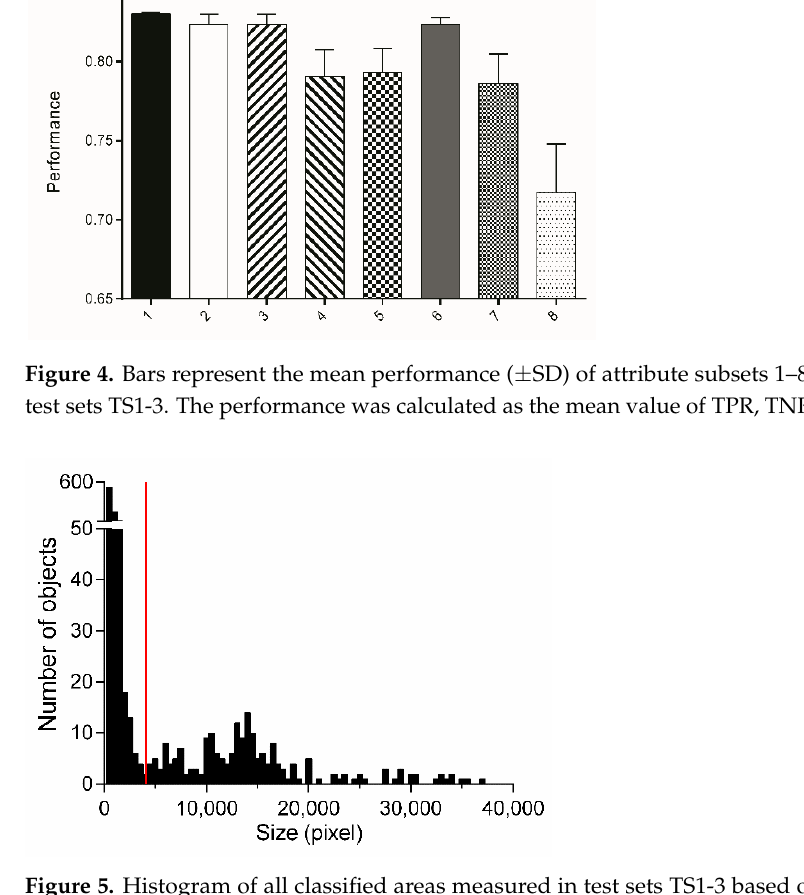
Bars represent the number of objects with a certain area (pixel); the red bar indicates the minimum